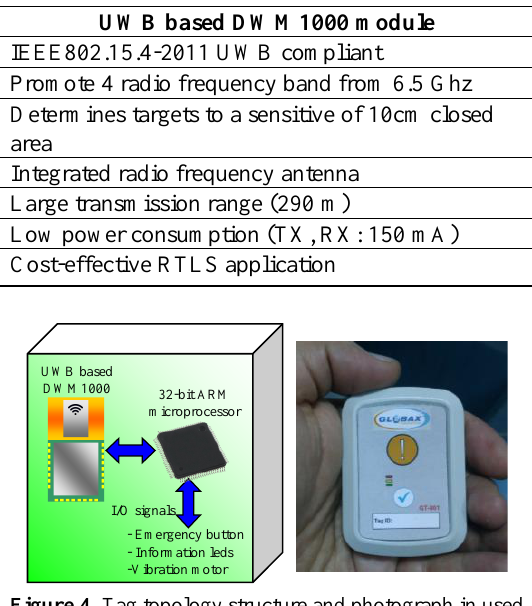
Table 1. DWM1000 module technical speciation [13].